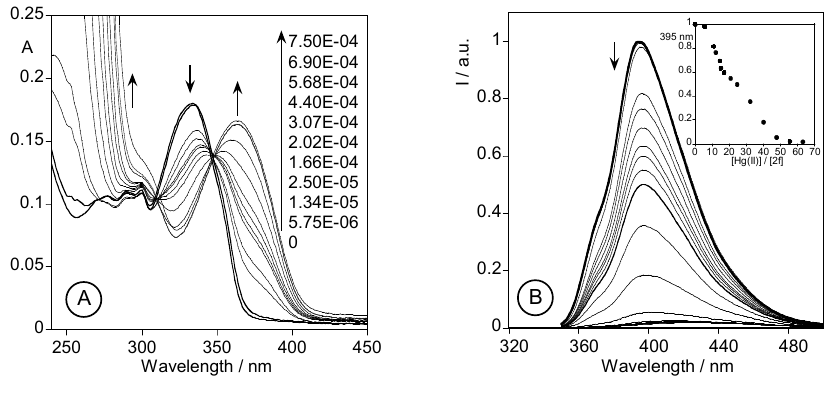
Figure 3. Spectrophotometric titration (A) and fluorimetric titration (B) of an ethanolic solution of 2f with a standard solution of Hg(CF